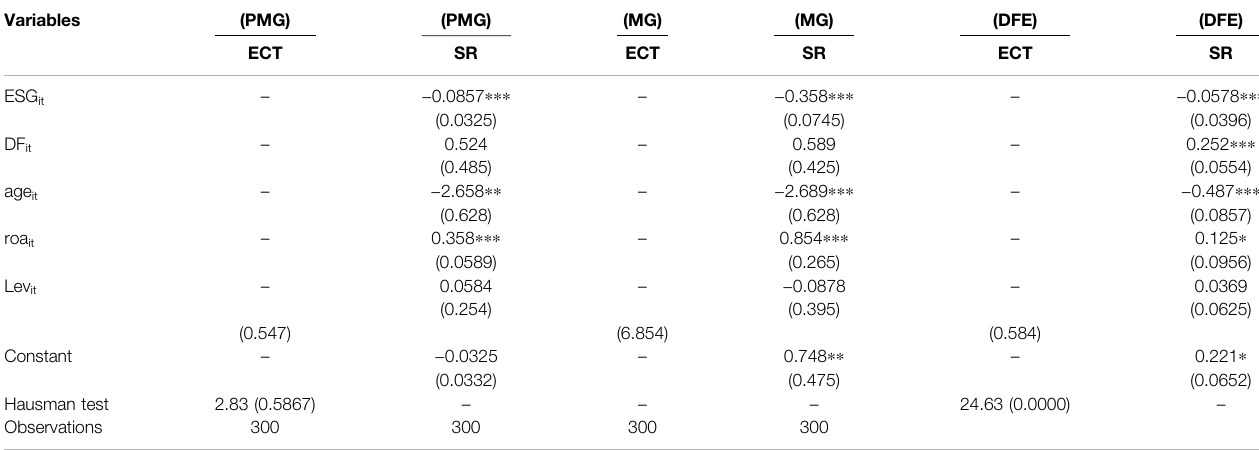
TABLE 4 | Econometric